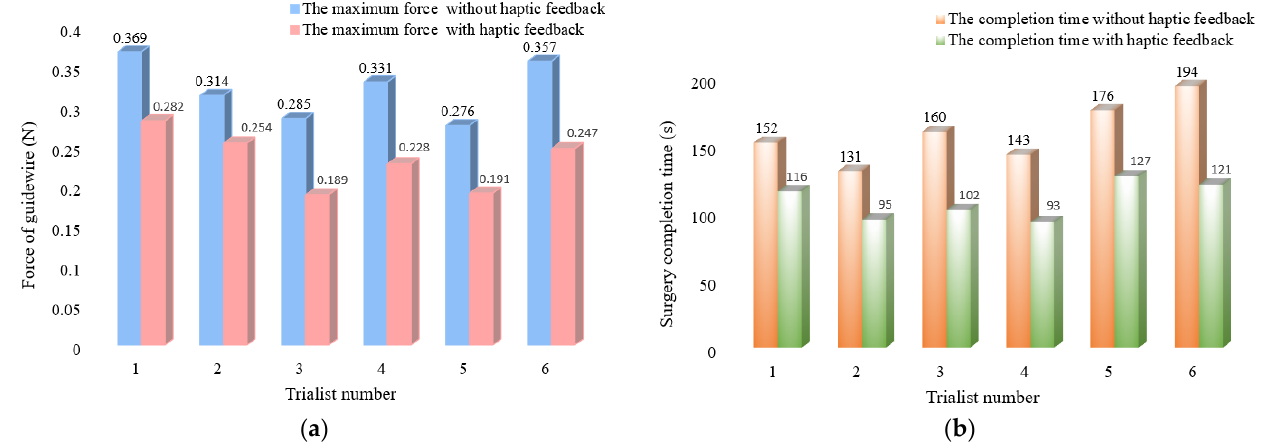
Figure 18. The statistical results for 6 trialists: ( a ) the maximum force value of guidewire without and with haptic feedback; ( b ) the surgery completion time for the operation task.